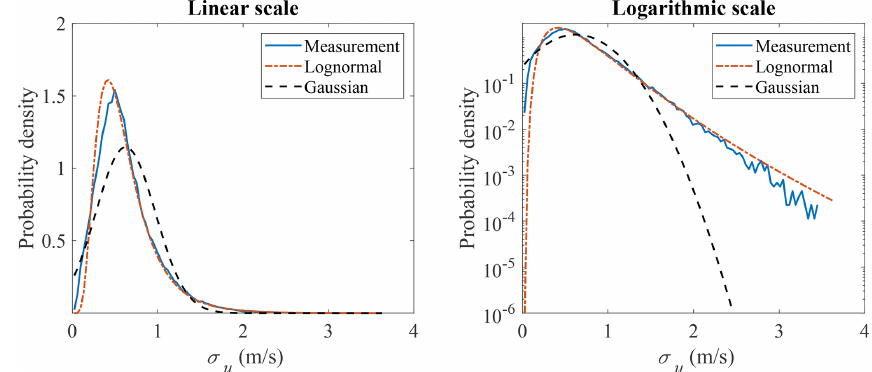
Figure 5. Marginal distribution of σ u with lognormal fitting.